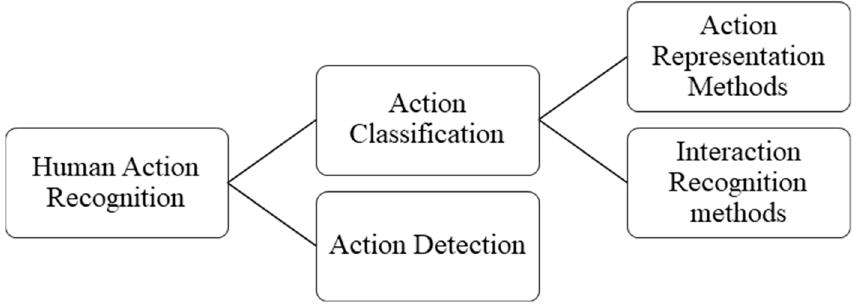
Figure 1. Classification framework for human action recognition methods.